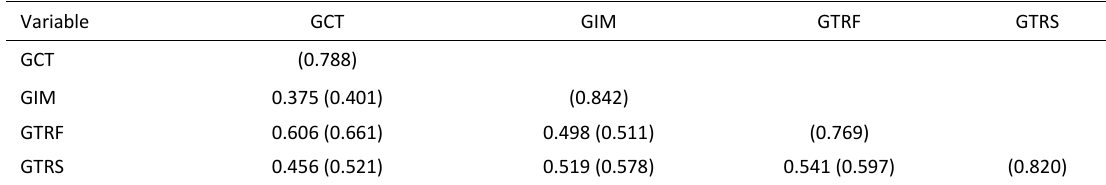
Fig. 1: Direct effect, structural model assessment and factor loading